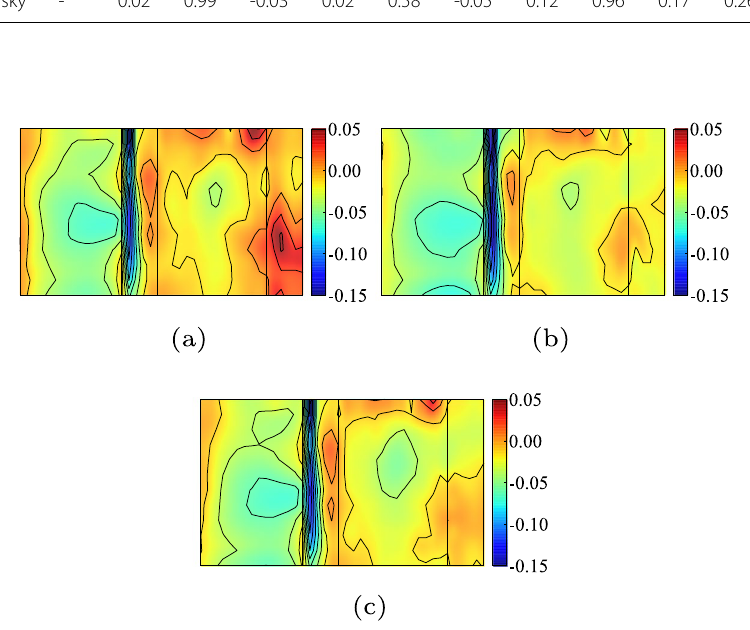
Fig. 17 The surface distributions of the PE C ′ ( c )